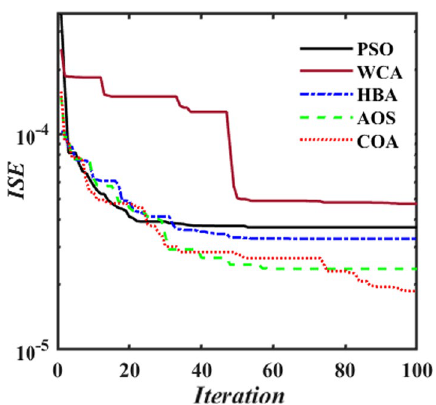
Fig. 9 Comparison of ISE convergence for the five optimizers of the two‑area power system including FOPID controllers